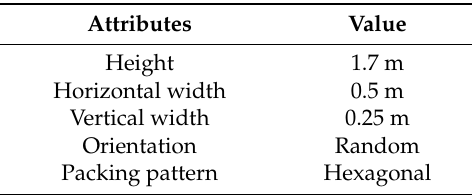
Table 1. Agent parameters.